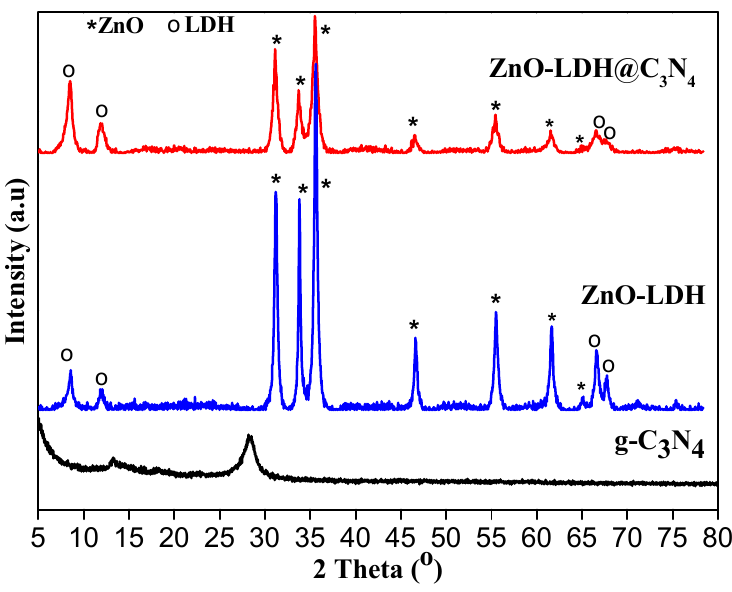
Figure 1. XRD patterns of g-C 3 N 4 , ZnO-LDH and ZnO-LDH@C 3 N 4 .